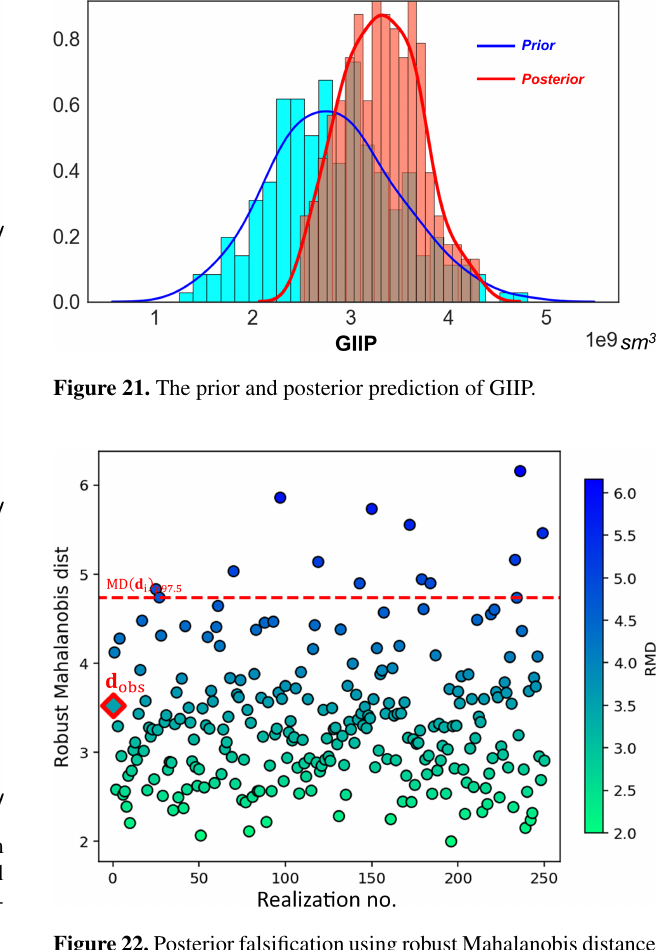
Figure 22. Posterior falsification using robust Mahalanobis distance outlier detection method using the data from w5 and